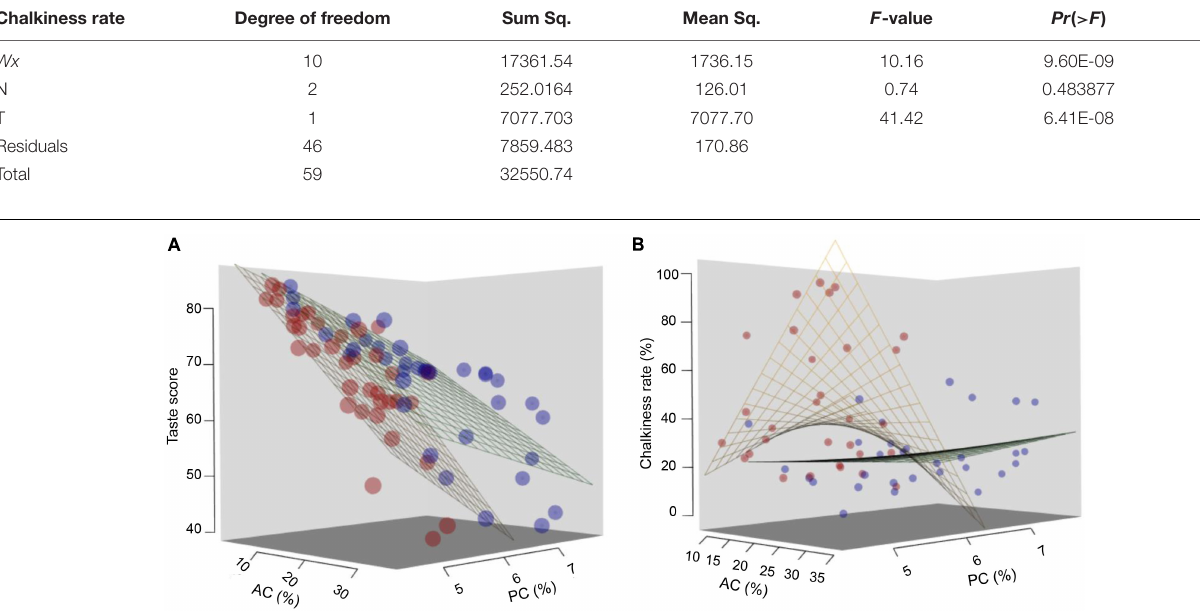
TABLE 3 | Three-way ANOVA on rice chalkiness rate (CR).